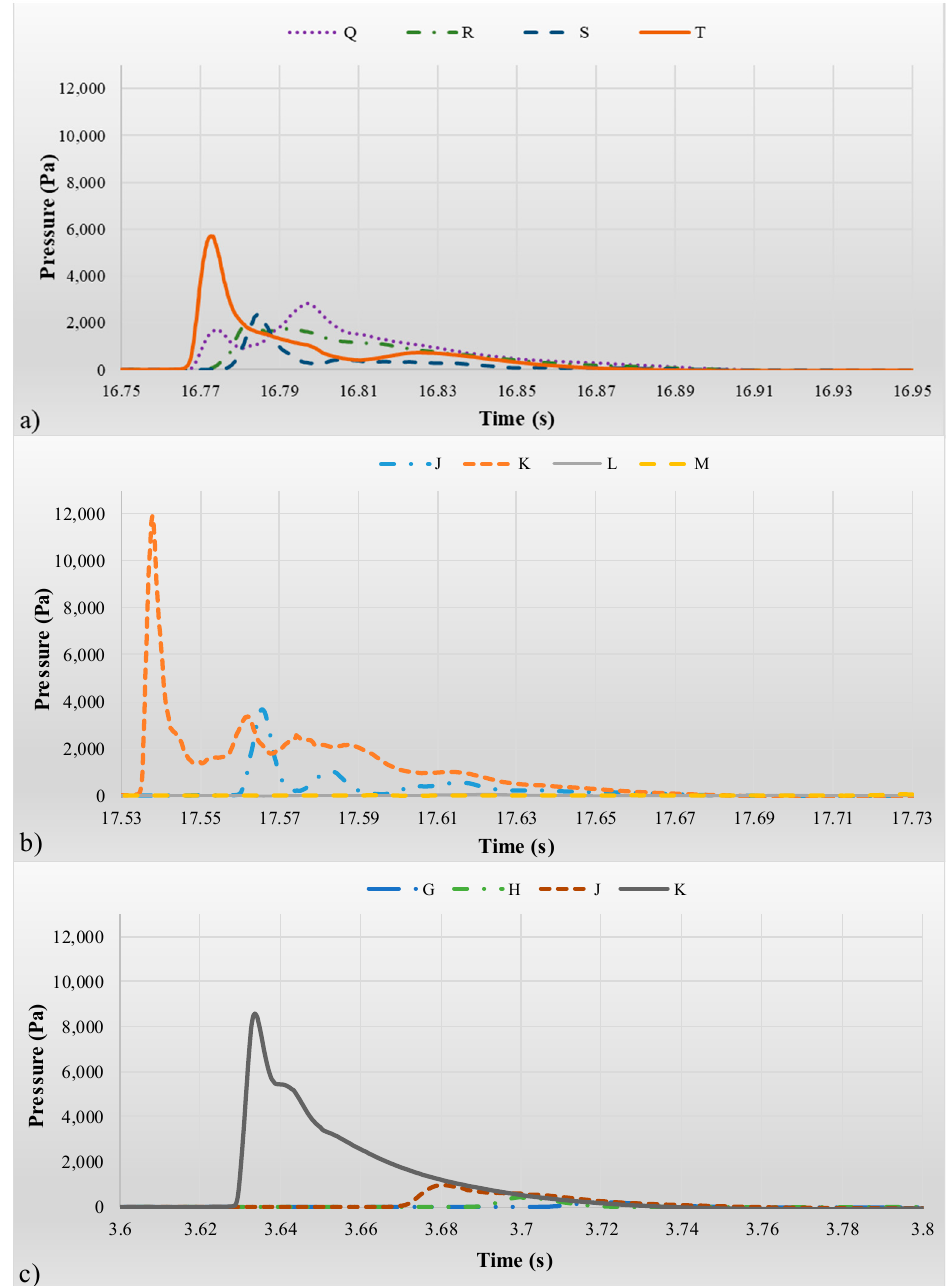
Figure 13. Comparison of pressure distributions for the tank with 100 mm water depth excited by harmonic resonance excitation at: ( a ) 0°, ( b ) 30°, and ( c ) 60° orientations.